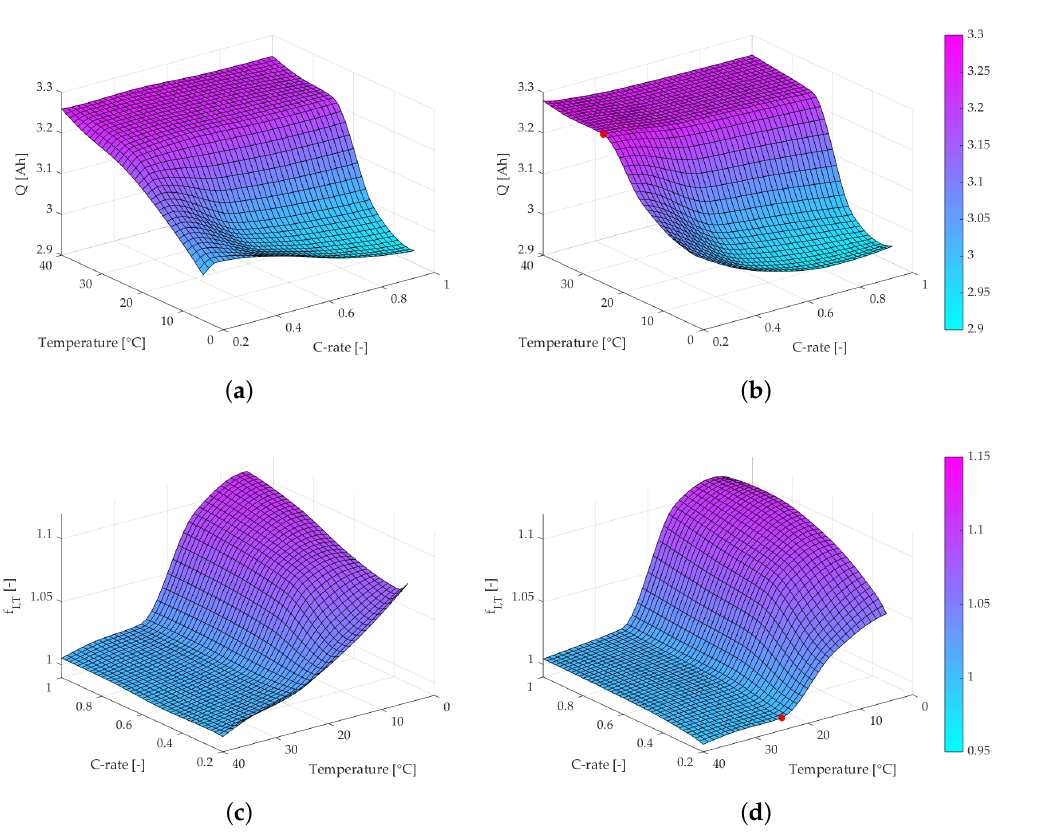
Figure 4. Charge and discharge capacity under different conditions ( a ) charge capacity, and ( b ) discharge capacity. Compensation factor for charging and discharging processes under different conditions ( c ) charge compensation factor, and ( d ) discharge compensation factor. The red dot represents the reference conditions (0.2C and 25 ◦